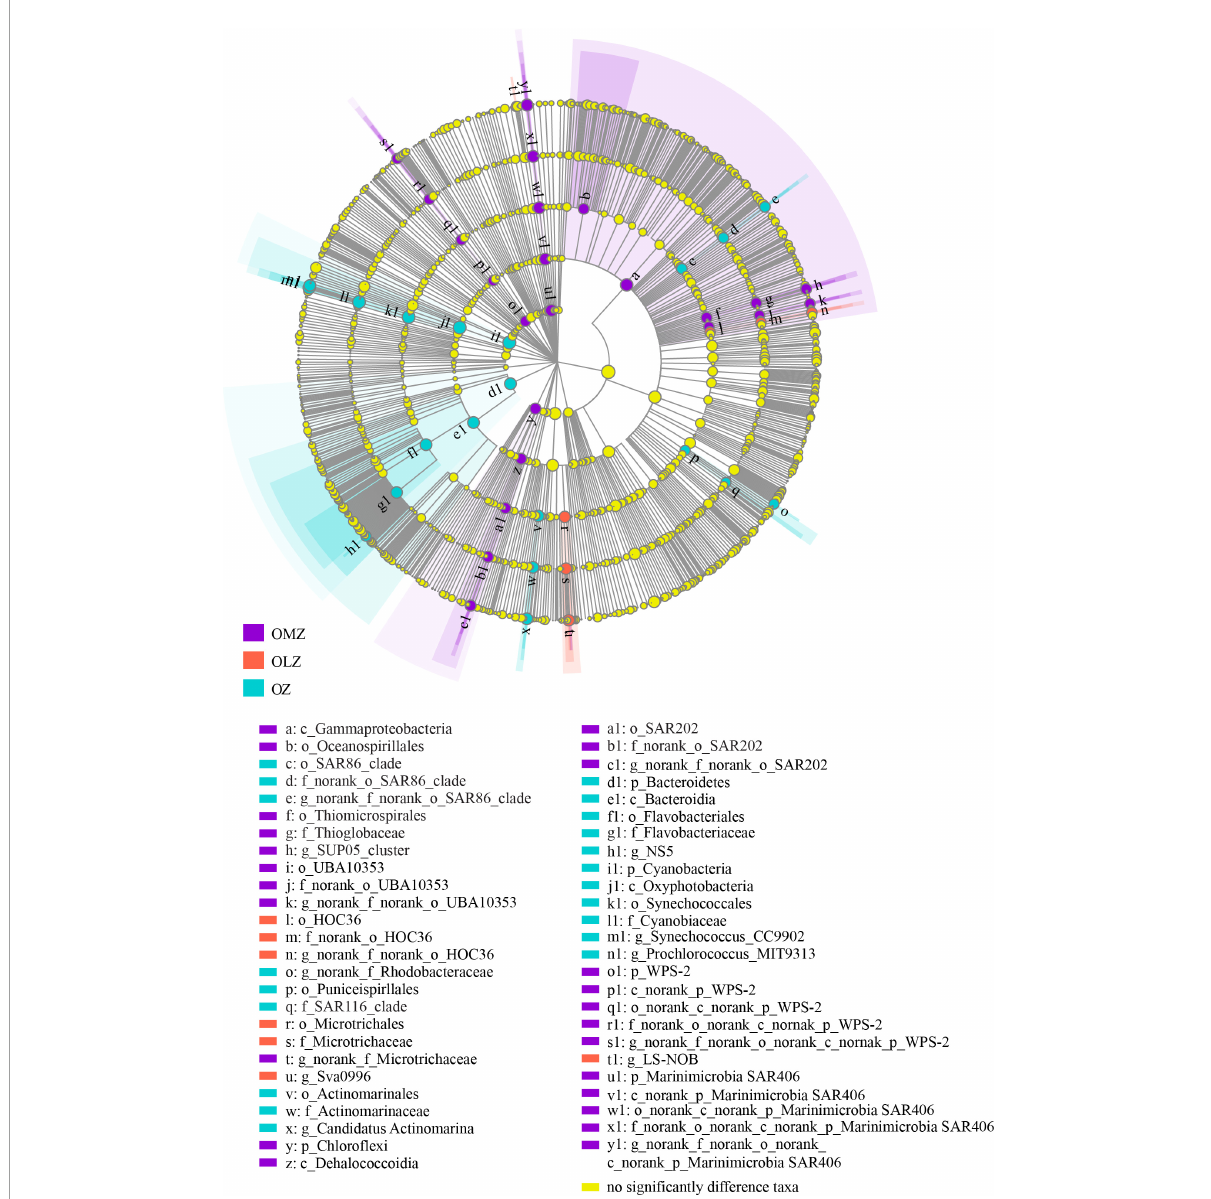
FIGURE4 Taxonomic cladogram showing distinctive taxa in the OMZ, OLZ, and OZ communities identified by LEfSe analysis. Enlarged colored circles show differentially abundant taxa in each sampling zone. Yellow dots mean the taxa that no significant different between OMZ, OLZ, and OZ